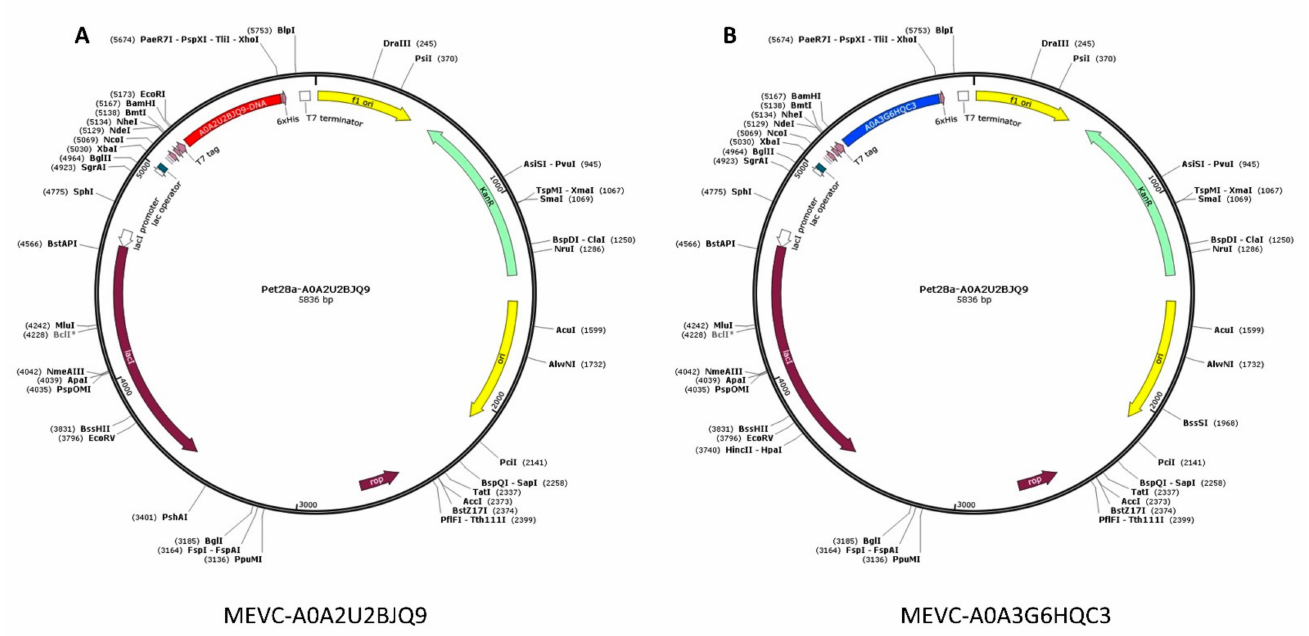
Figure 5. The in silico cloning designs (plasmid maps) in the Pet-28 expression vector using ECORI and XhoI restriction sites for the MEVCs (DNA sequence) against target proteins of Alcaligenes faecalis . Figure ( A ) shows the in silico cloning design for MEVC-A0A2U2BJQ9 (red color) in the Pet28 vector, while ( B ) shows the in silico cloning design for MEVC-A0A3G6HQC3 (blue color) in the Pet28